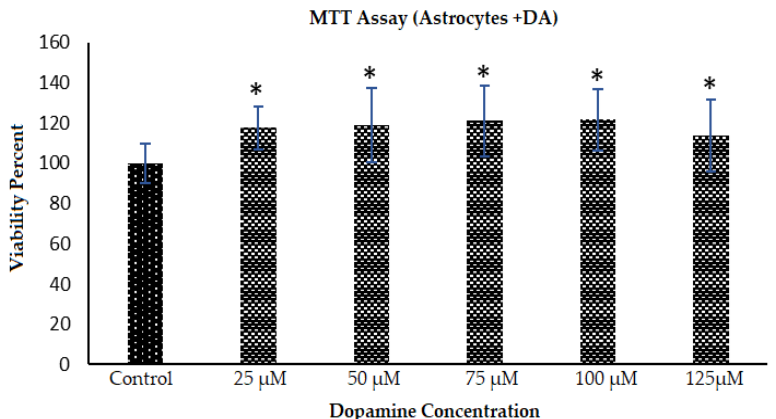
Figure 6. Metabolic activity of incubated astrocytes with DA treatment. Astrocytes were plated at 5000 cells / well each and then allowed to grow for 7 days, and treated with DA at indicated concentrations. PDA was allowed to form for the next 2 days when the MTT viability assay (see Methods) was used to assess the cellular metabolic activity. Data are from multiple platings of cells for each condition and * denotes p < 0.05 compared to control condition.